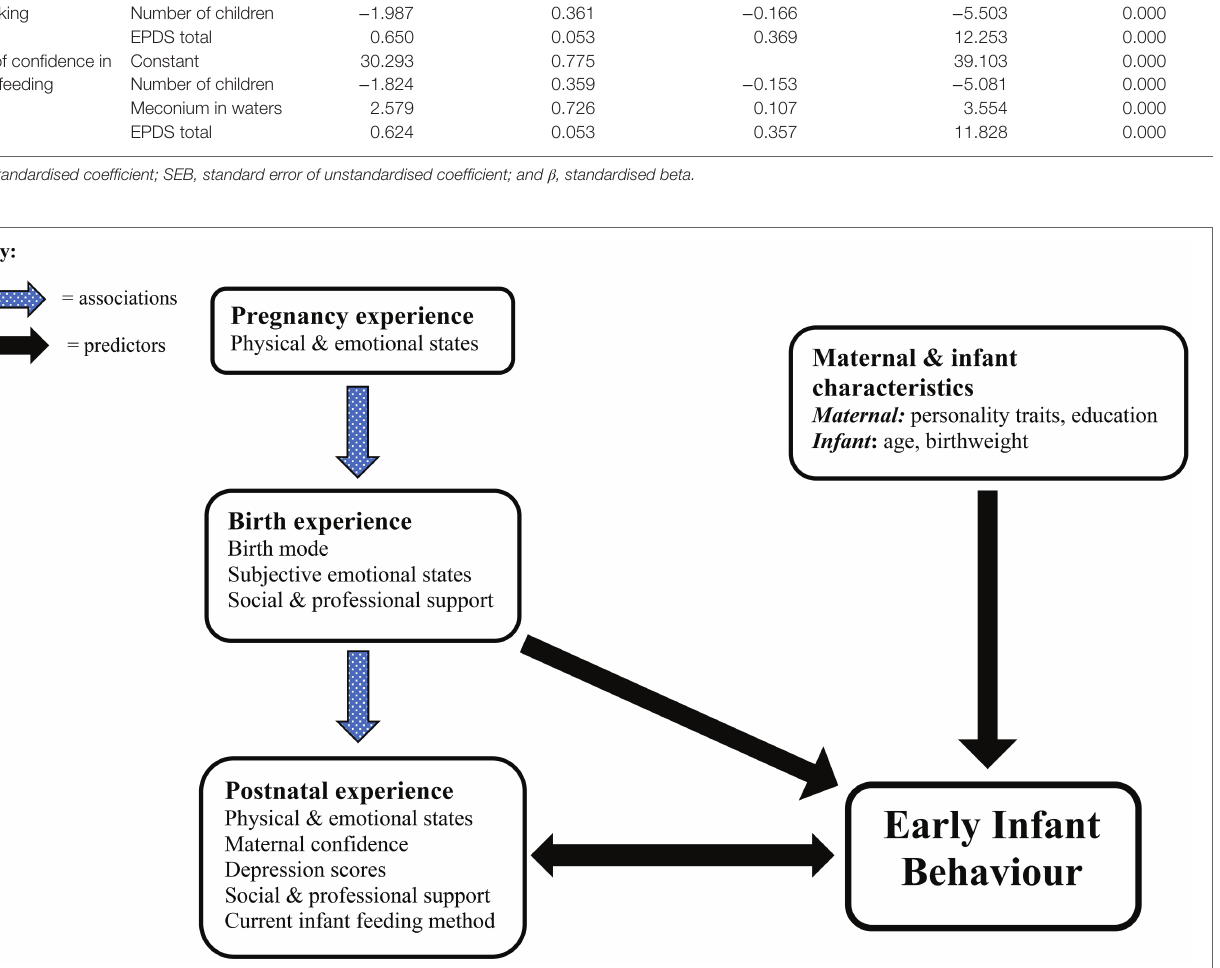
FIGURE 1 | Representation of findings—perinatal factors contributing to early infant behaviour.